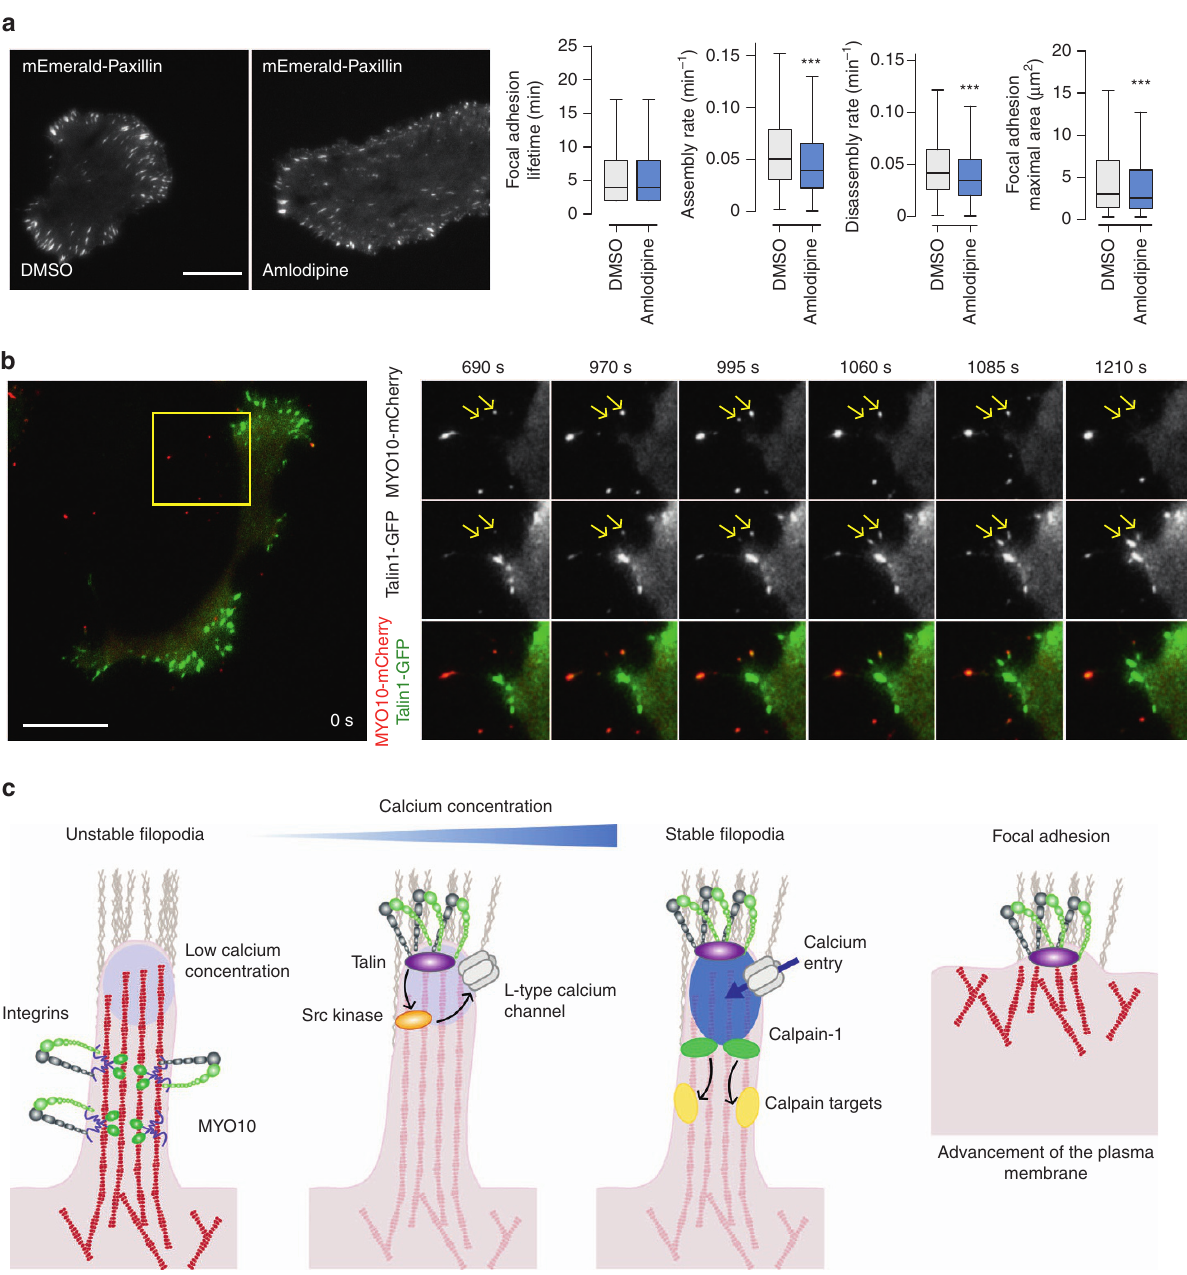
Figure 8 | Filopodia stabilization directs cell migration. ( a ) MDA-MB-231 cells transiently expressing mEmerald-Paxillin were plated on FN and imaged live using a TIRF microscope (1 picture every 1min over 3h; scale bar, 20 m m) in the presence of DMSO or amlodipine besylate (10 m M). Focal adhesion properties were analysed using the focal adhesion analysis server 53 (three biological repeats; over 33 movies per condition analysed; adhesion lifetime and maximal area, n 4 112,000 adhesions analysed; assembly rate, n 4 6100 adhesions analysed; disassembly rate, n 4 7,200 adhesions analysed, *** P value o 1.73 (cid:3) 10 (cid:2) 50 ). P values were calculated using Student’s t -test (unpaired, two-tailed, unequal variance). ( b ) MDA-MB-231 cells transiently expressing talin-1-GFP and MYO10-mCherry were plated on FN and imaged live using a TIRF microscope (1 picture every 5s; scale bar, 20 m m). Images of the region of interest (yellow squares) at the time point of interest are displayed on the right. Yellow arrows highlight MYO10-positive filopodia that precede mature focal adhesions. ( c ) Cartoon representing the sequence of events, identified in this study, leading to filopodia stabilization and ultimately focal adhesion formation. Briefly, unstable filopodia are extended from the plasma membrane to tether the surrounding environment. These filopodia display low calcium concentration at their tips. Molecular motors such as MYO10 transport integrins and other adhesion receptors to filopodia tips. Upon integrin activation, the kinase Src, directly or indirectly, promotes L-type calcium channel activity resulting in increased calcium concentration at filopodia tips. Higher calcium concentration at filopodia tips promotes calpain-1 activation and filopodia stabilization. Ultimately, upon plasma membrane advancement, adhesions initiated at filopodium tips/shafts precede mature classical focal Quantitative RT-PCR . Total RNA extracted using the NucleoSpin RNA Kit manufacturer’s instructions. The RT-PCR reactions were performed using prede- signed single tube TaqMan gene expression assays (GAPDH: Hs03929097_g1; (Macherey-Nagel) was reverse transcribed into cDNA using the high-capacity CACNA1D : Hs00167753_m1; CACNA1C : Hs00167681_m1; CACNA1F : cDNA reverse transcription kit (Applied Biosystems) according to the